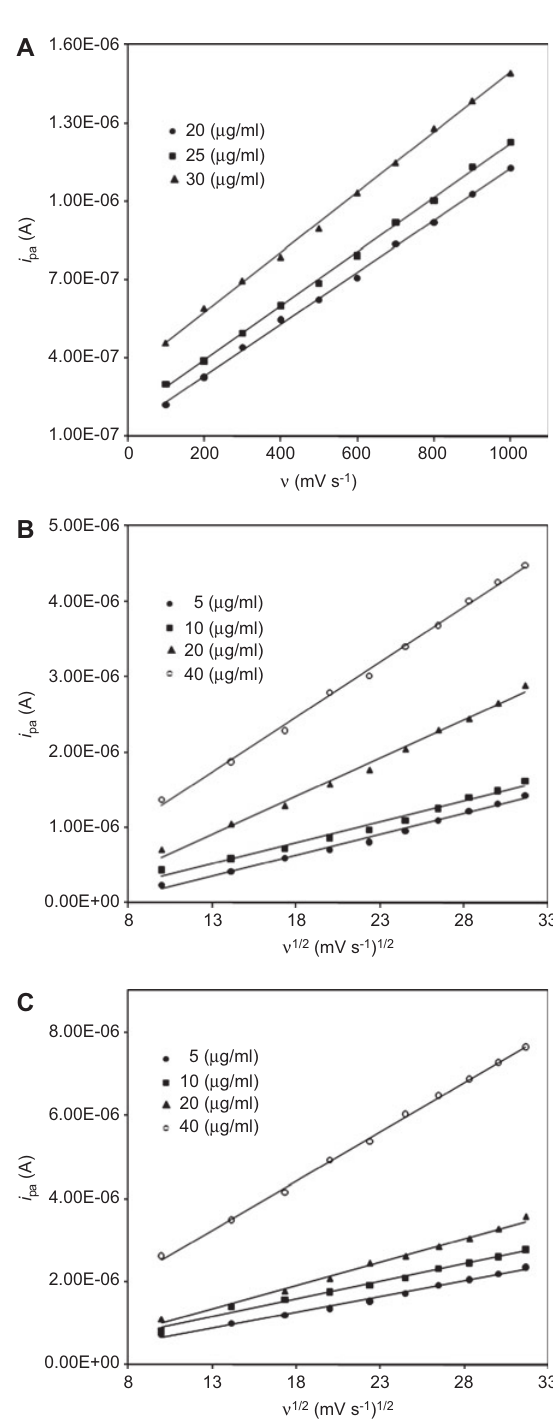
Figure 4 Dependence of peak currents for (A) peak A, (B) peak B as a func- 4 and (C) peak C on the scan rate.